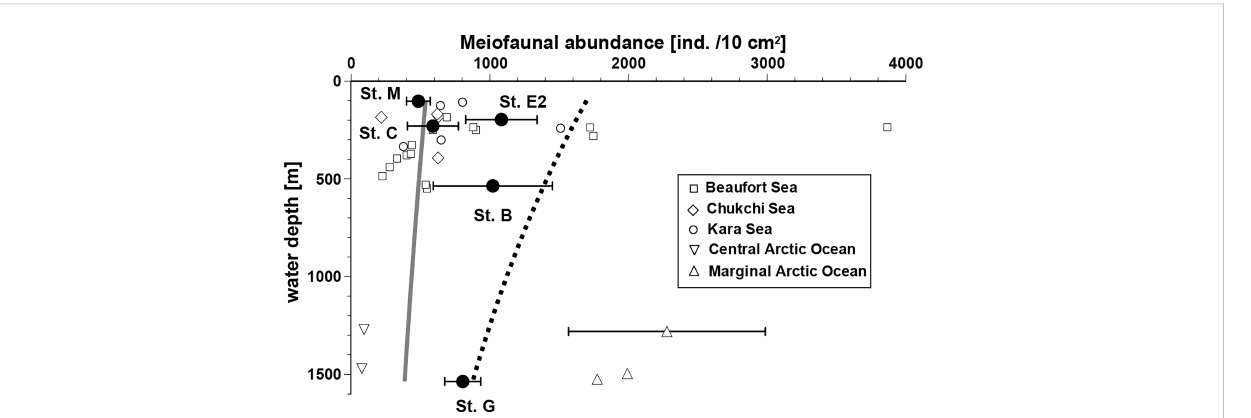
FIGURE 2 Relationships between water depth and total meiofaunal abundance (mean ± SD, if replicate data available) in the southeastern Bering Sea and in the other sites with similar depths in the adjacent Arctic Seas. Data from the other seas in the Arctic Ocean were obtained from the following sources: Beaufort Sea, Bessière et al. (2007); Chukchi Sea, Lin et al. (2014) and Huang et al. (2021); Kara Sea, Portnova and Polukhin (2018); Central Arctic Ocean, Schewe (2001); Marginal ice zone of Arctic Ocean, Hoste et al. (2007) and Soltwedel et al. (2020). The gray line presents